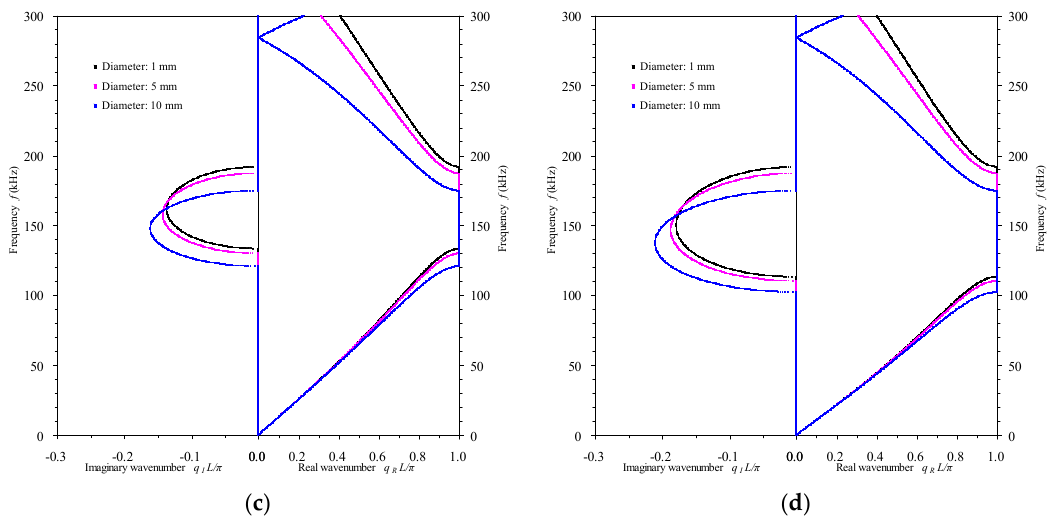
Figure 7. Influence of the rod’s cross-sectional dimension on the propagation constants spectra of the periodic PZT-5H piezoelectric rod covered by brass electrodes with periodic electrical boundaries: ( a ) electric-open condition; ( b ) applied electric capacity condition with C “ α A { l ; ( c ) electric-short condition; and ( d ) applied feedback control condition with K g “ 5 ˆ 10 8 V { m.